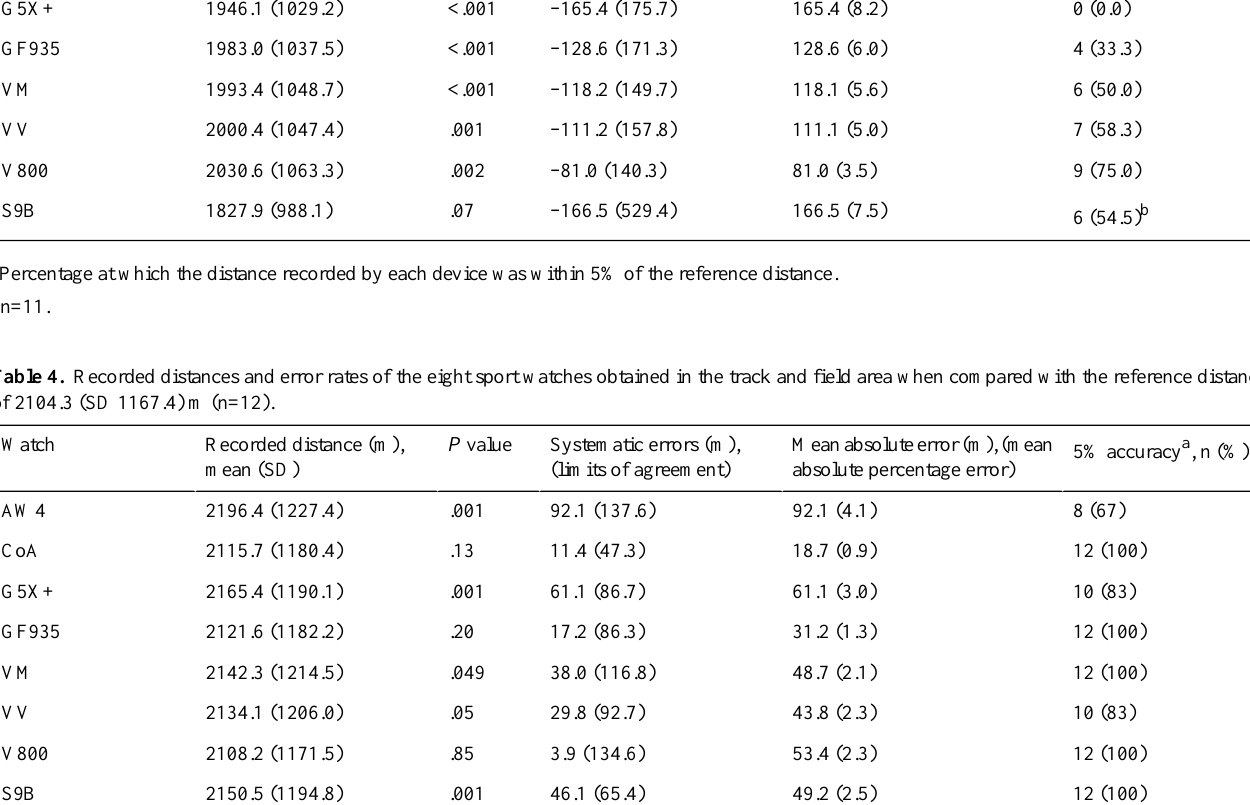
between 18.3% of the variance in the MAE in the AW4 and 44.2% in the CoA. The running category was the most shown predictor; in six watches, it remained and had a significant influence on the final regression models and explained between <1% and 9% of the MAE in the respective